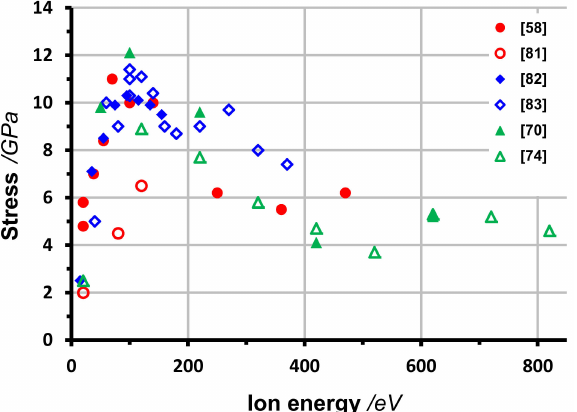
Figure 16. Dependence of the compressive stress on the ion energy for carbon films, deposited by filtered dc vacuum arc. Included values for filtered anodic Laser-Arc [58,70,74,81–83]. Empty symbols: ion energy ≈ 20 eV + e U bias .